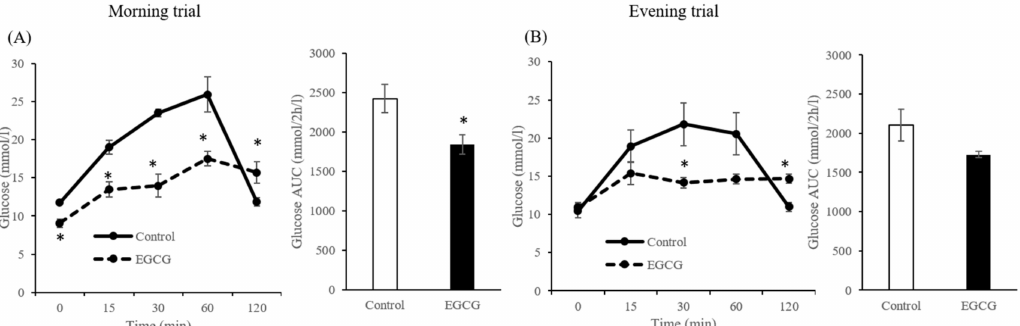
Figure 3. Concentrations and incremental area under the curve (AUC) of plasma glucose in the morning ( A ) and evening ( B ) trials in mice. Data are expressed as the mean and SEM, represented by bidirectional bars. * Mean values were significantly di ff erent from that of control group at same time.